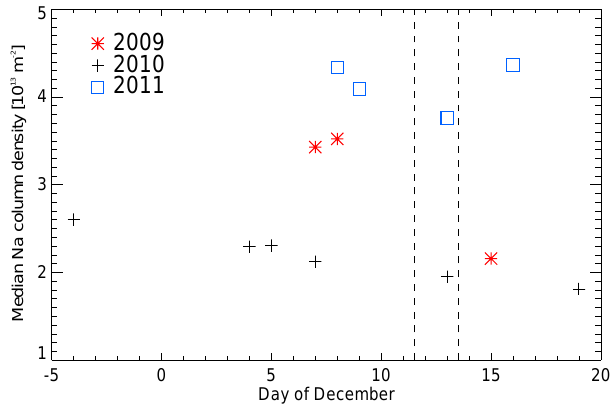
Fig. 7. Time series of daily median value of Na column density (in 10 13 m − 2 ) as a function of date. Only data for the beam pointed north with a zenith angle of 20 ◦ is shown for 2009 (red stars) and 2010 (black plus signs). Data for 2011 (blue squares) is the median of the five-minute averages from both beams pointed to zenith. The measurement uncertainty is two orders of magnitude smaller, and is therefore not plotted. See Figs. 3 to 5 for the geophysical vari- ability. The vertical dashed lines indicate the approximate period of the Geminids peak activity. Dates are given as day of December, i.e. “ − 4” corresponds to 26 November.